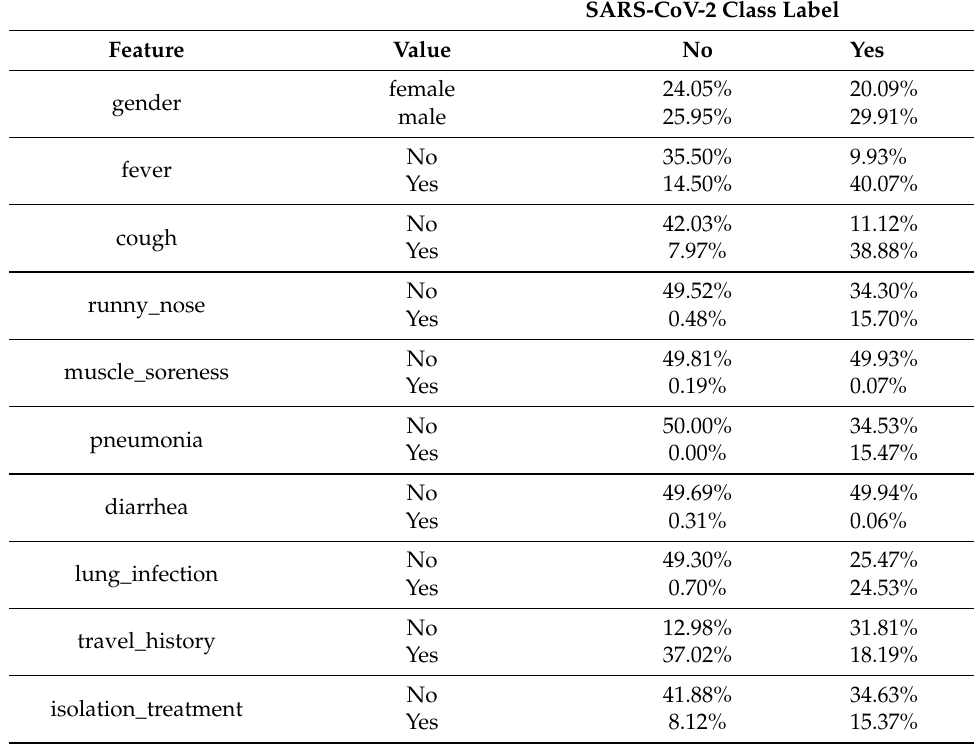
Table 2. Participants distribution per feature value and class label in the balanced dataset af- ter